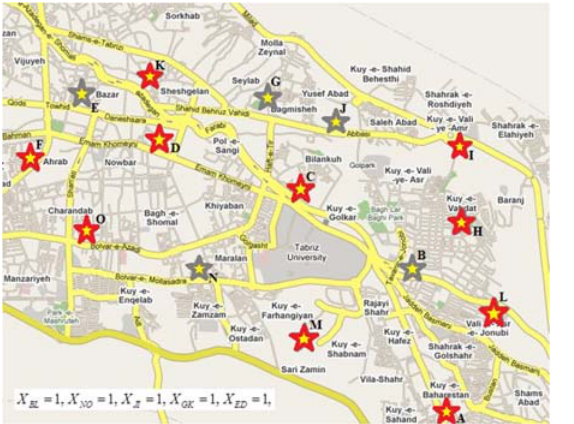
Fig. 4. Optimal locations of ten stations by hybrid- based